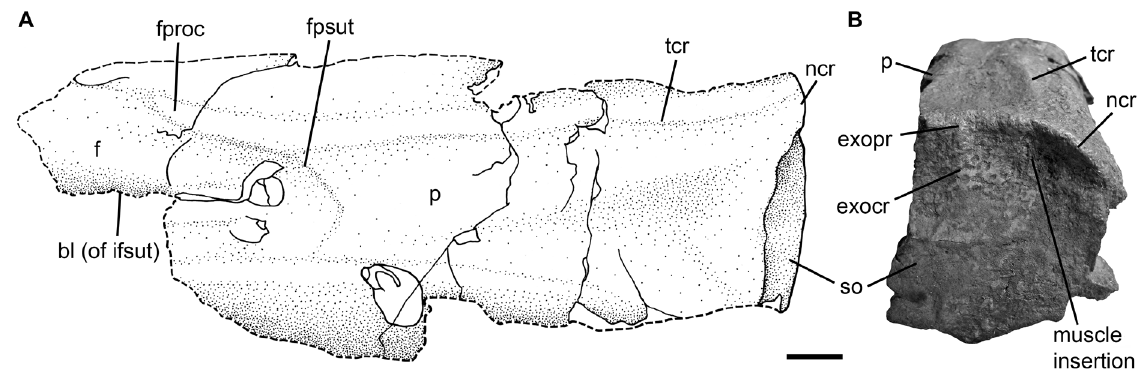
Fig. 5. Parietal-supraoccipital skullcap of Lentiarenium cristolii ( Fitzinger, 1842) (OLL 1899/11, holotype of “Halitherium” pergense (Toula, 1899)). A . Drawing in dorsal view. B . Photograph in caudal view. White areas indicate either missing or reconstructed parts. Dashed lines pertain to broken parts. Scale bar = 1